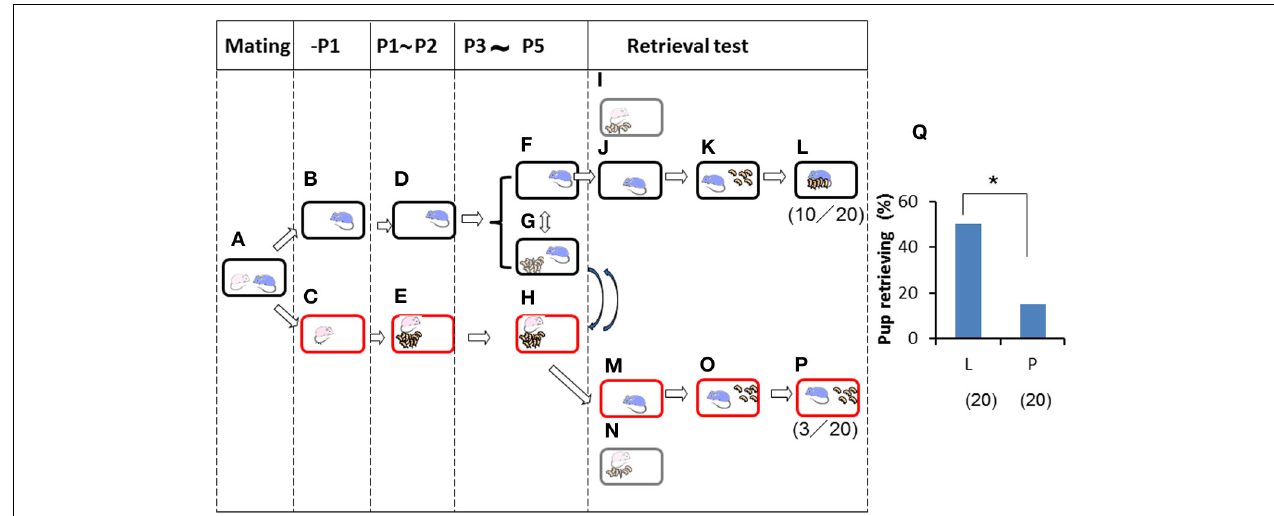
the rest of the time, the sires stayed alone in the home cages (F) and the dams were with the pups (H) . Pup retrieval behavior over a period of 10min was examined at P5 ( I–L and M–P , respectively). The number of sires displaying retrieval behavior was scored (L,P) , and the numbers of positive mice/number of mice tested are shown in parentheses. Pup retrieval was expressed as percentages ( Q ; ∗ P < 0 . 05 between old (L) and new (P) cages, two-tailed Fisher’s exact probability